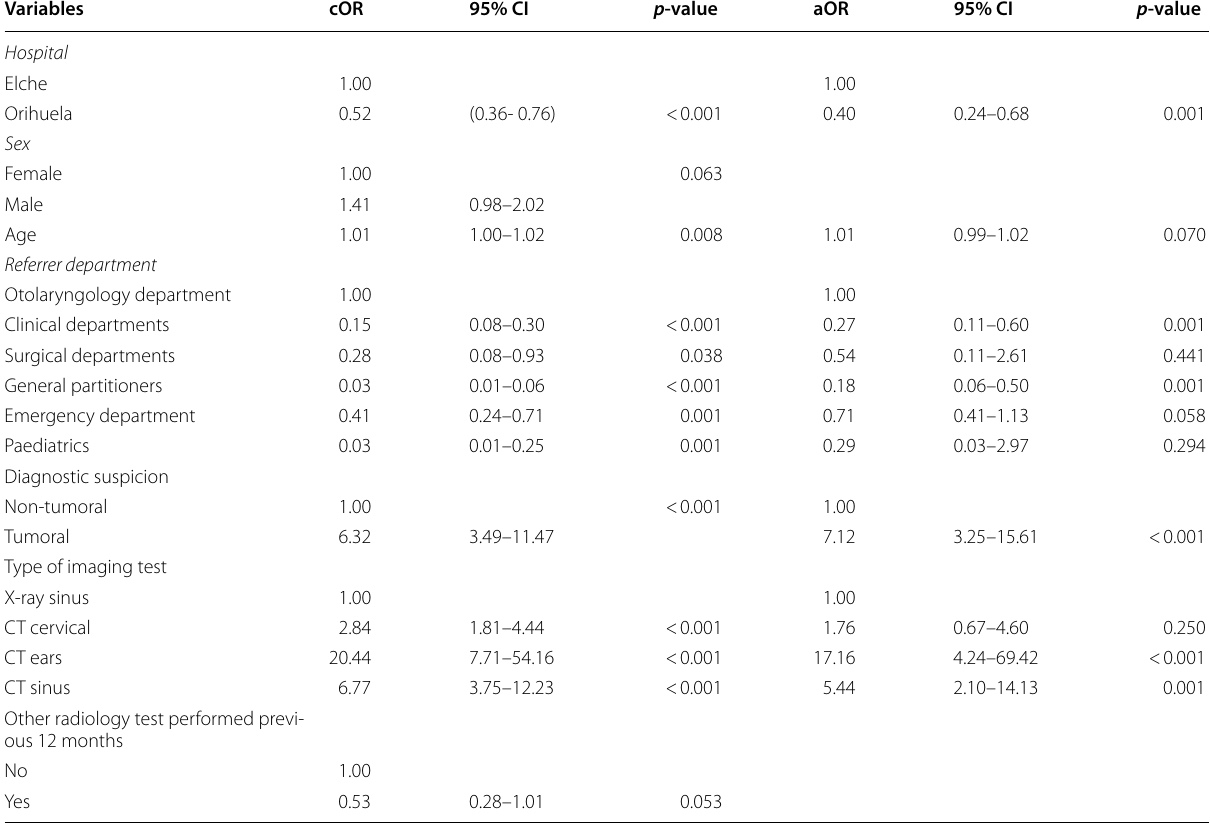
Table 2 Crude (cOR and 95% CI) and multivariable a (aOR and 95% CI) association among imaging test appropiatness b and the variables of the